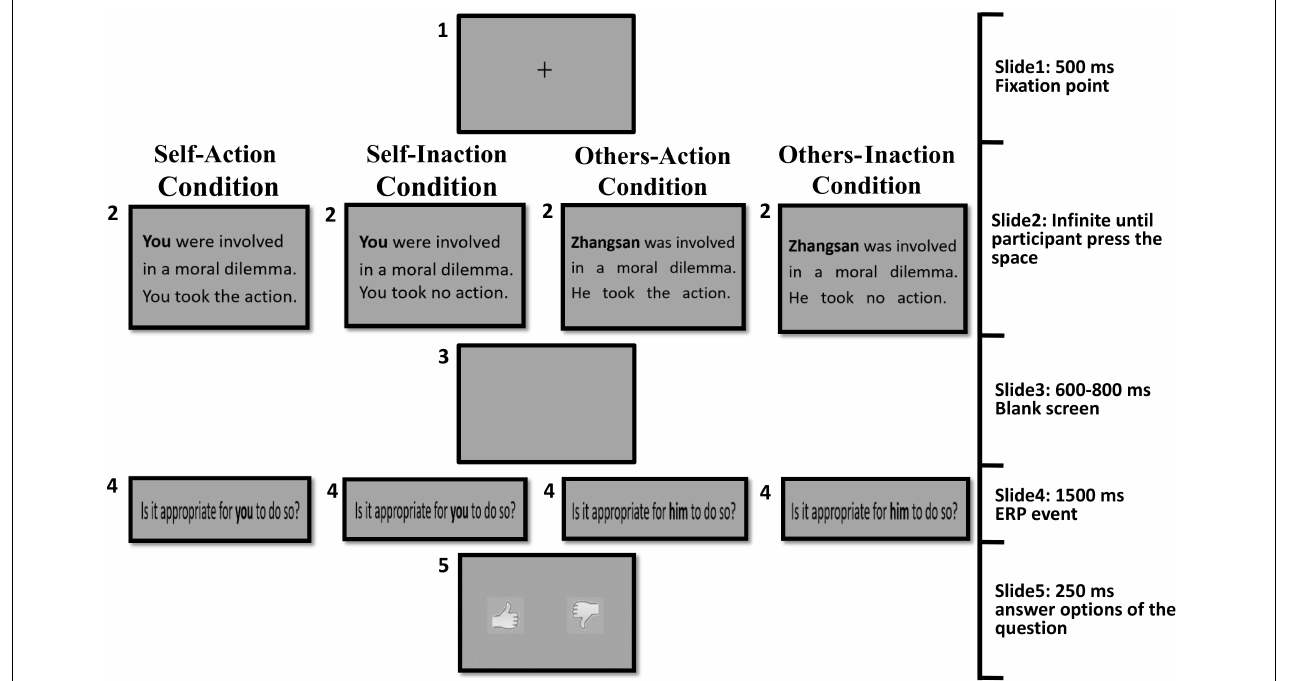
FIGURE 1 | The procedure for the four experimental